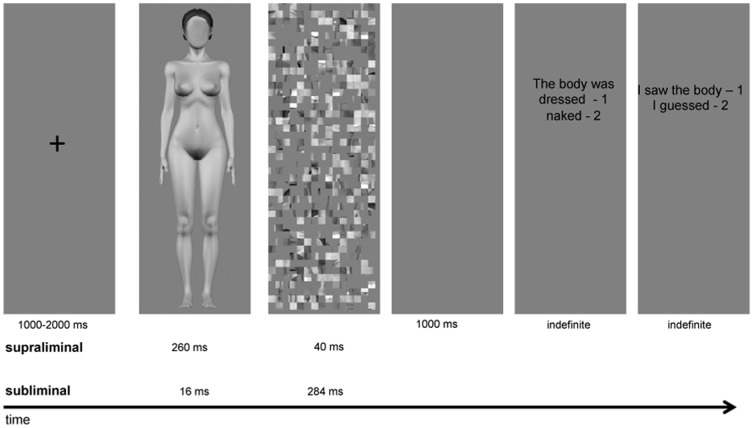
Experimental procedure.An initial fixation cross was presented for random durations between 1000 to 2000 ms, followed by a target for 260 ms in the supraliminal condition and 16 ms in the subliminal condition, followed by a mask for respectively 40 or 284 ms. The questions appeared after a 1000 ms delay. The participants answered by pressing a key, which then prompted the second question and subsequently initiated the next trial.